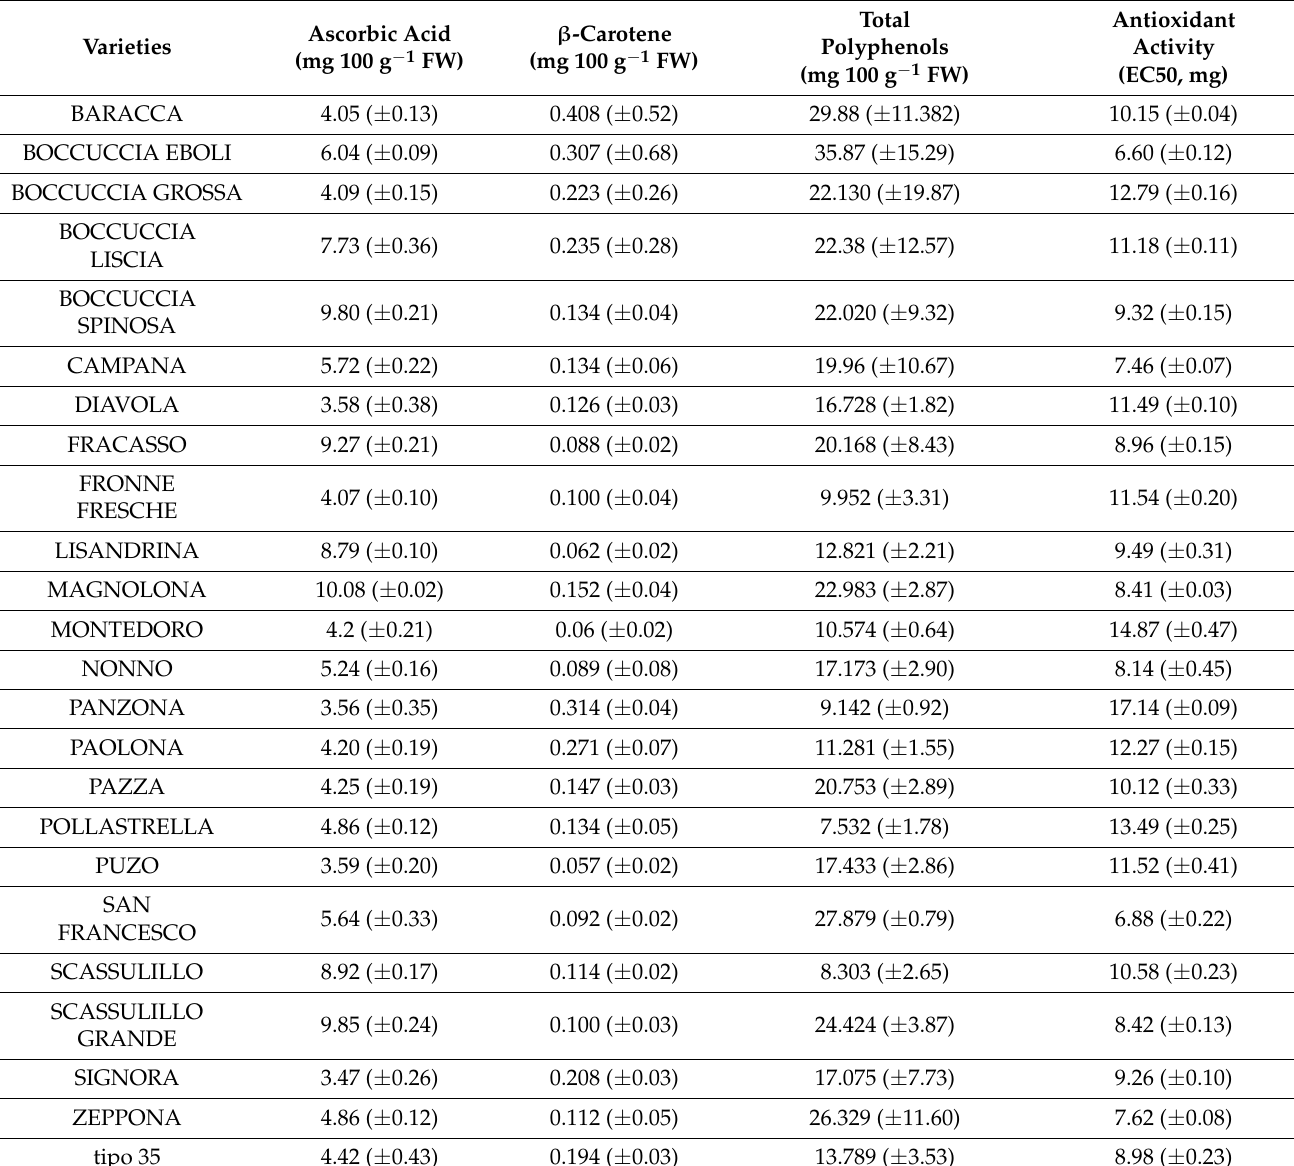
Table 1. Content of ascorbic acid, β -carotene, total polyphenols and antioxidant activity exhibited by the traditional varieties of apricots of the Campania region. Data represent the average ( ± SD) of three independent experiments. FW: fresh